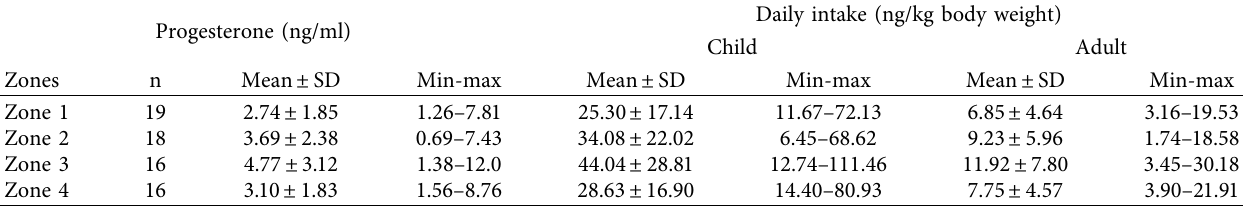
Table 4: Milk progesterone level and its daily intake in the different regions of Hamadan, Iran.